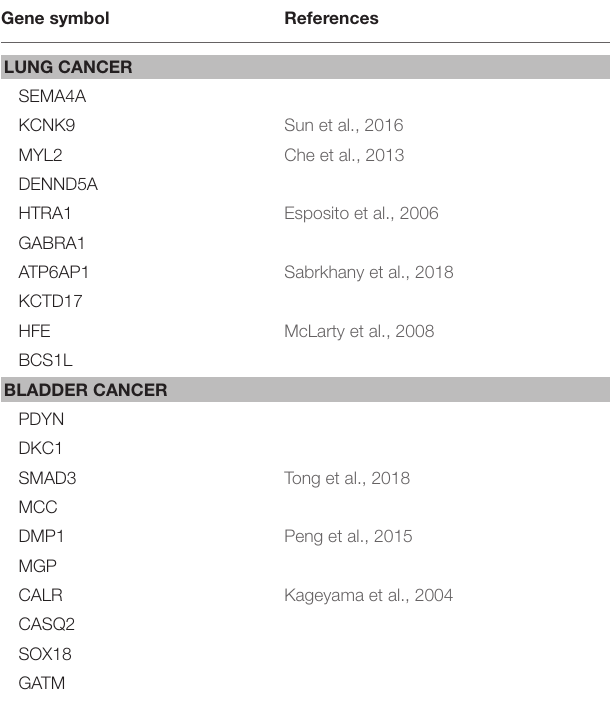
TABLE 1 | Top 10 predictions for lung cancer and bladder